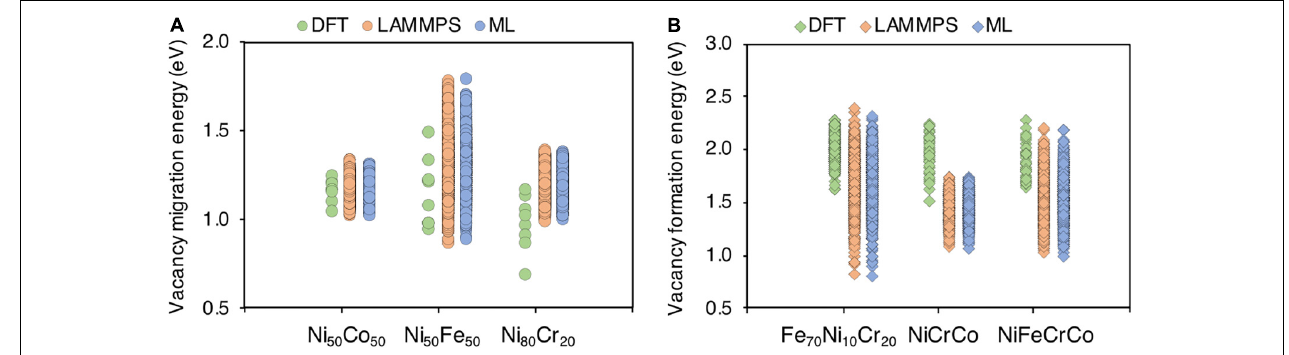
FIGURE 14 | Comparison between DFT, classical interatomic (LAMMPS) and machine learning predicted (ML) point defect energies in various alloy systems (A) vacancy migration energies and (B) vacancy formation energies.